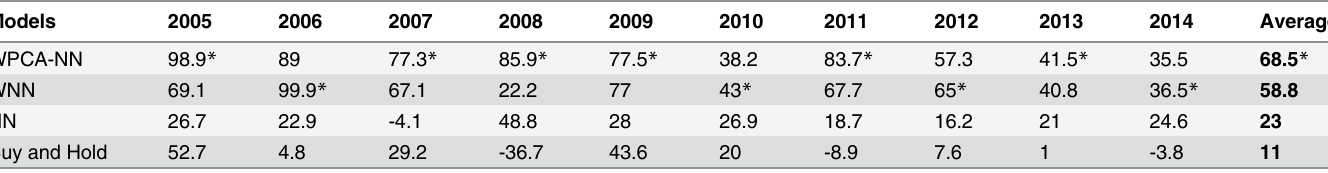
Table 6. Return of the models, results for KOSPI futures. Models